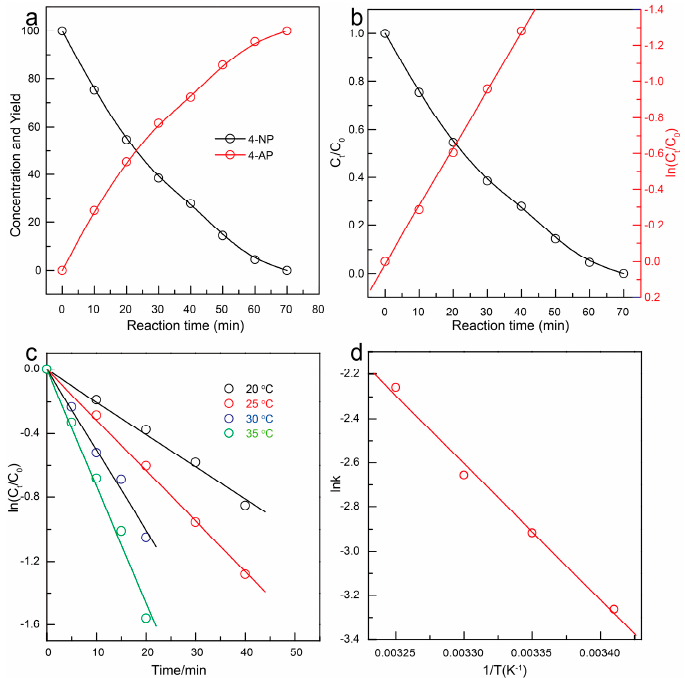
Figure 5. ( a ) Time evolution of the yield of 4-AP and conversion of 4-NP with the Pd/alk-Ti 3 C 2 X 2 catalyst at 25 °C. ( b ) Plots of ( C t / C 0 ) and ln( C t / C 0 ) vs. time for the reduction of 4-NP. ( c ) Plots of ln ( C t / C 0 ) vs. time at different temperatures. ( d ) The Arrhenius plot.